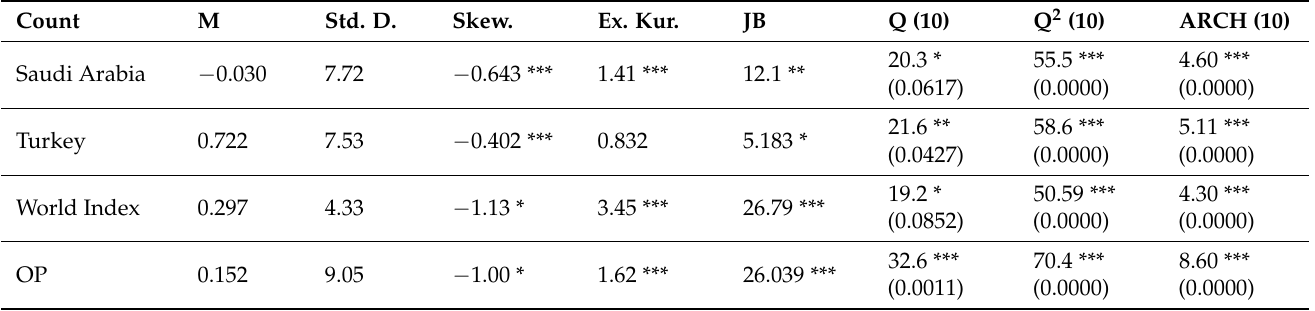
Table 1. Descriptive statistics for monthly return series (January 2005–December 2018).